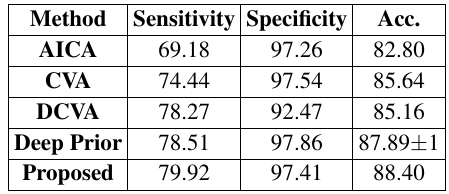
Table 4. Quantitative comparison for the Bay Area